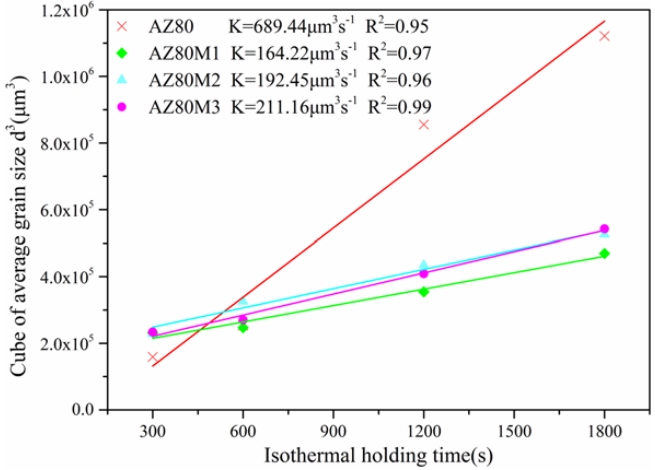
Figure 10. Effect of Y addition on the coarsening kinetics at 570 ◦